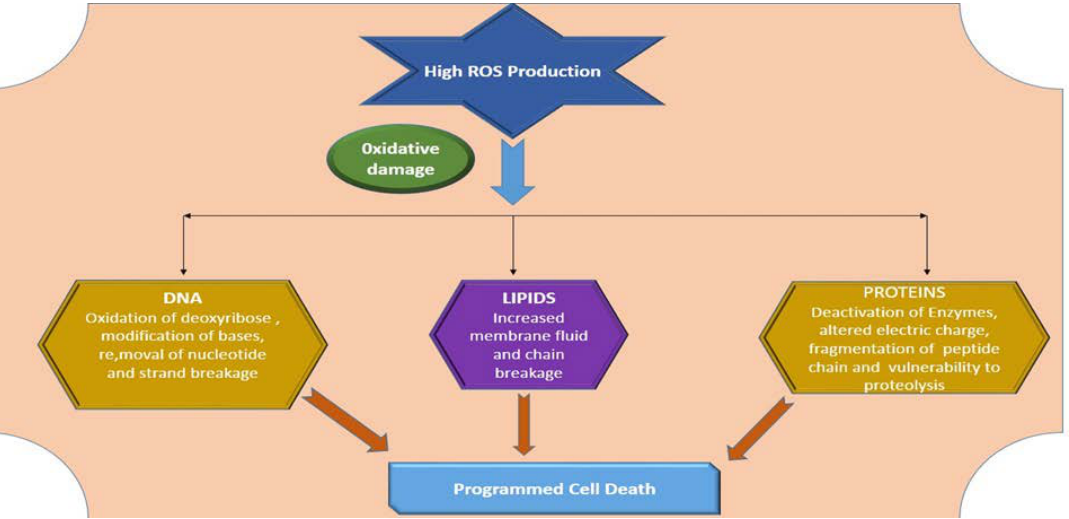
Figure 4. Reactive oxygen species (ROS)-induced oxidative damage to DNA, lipids and